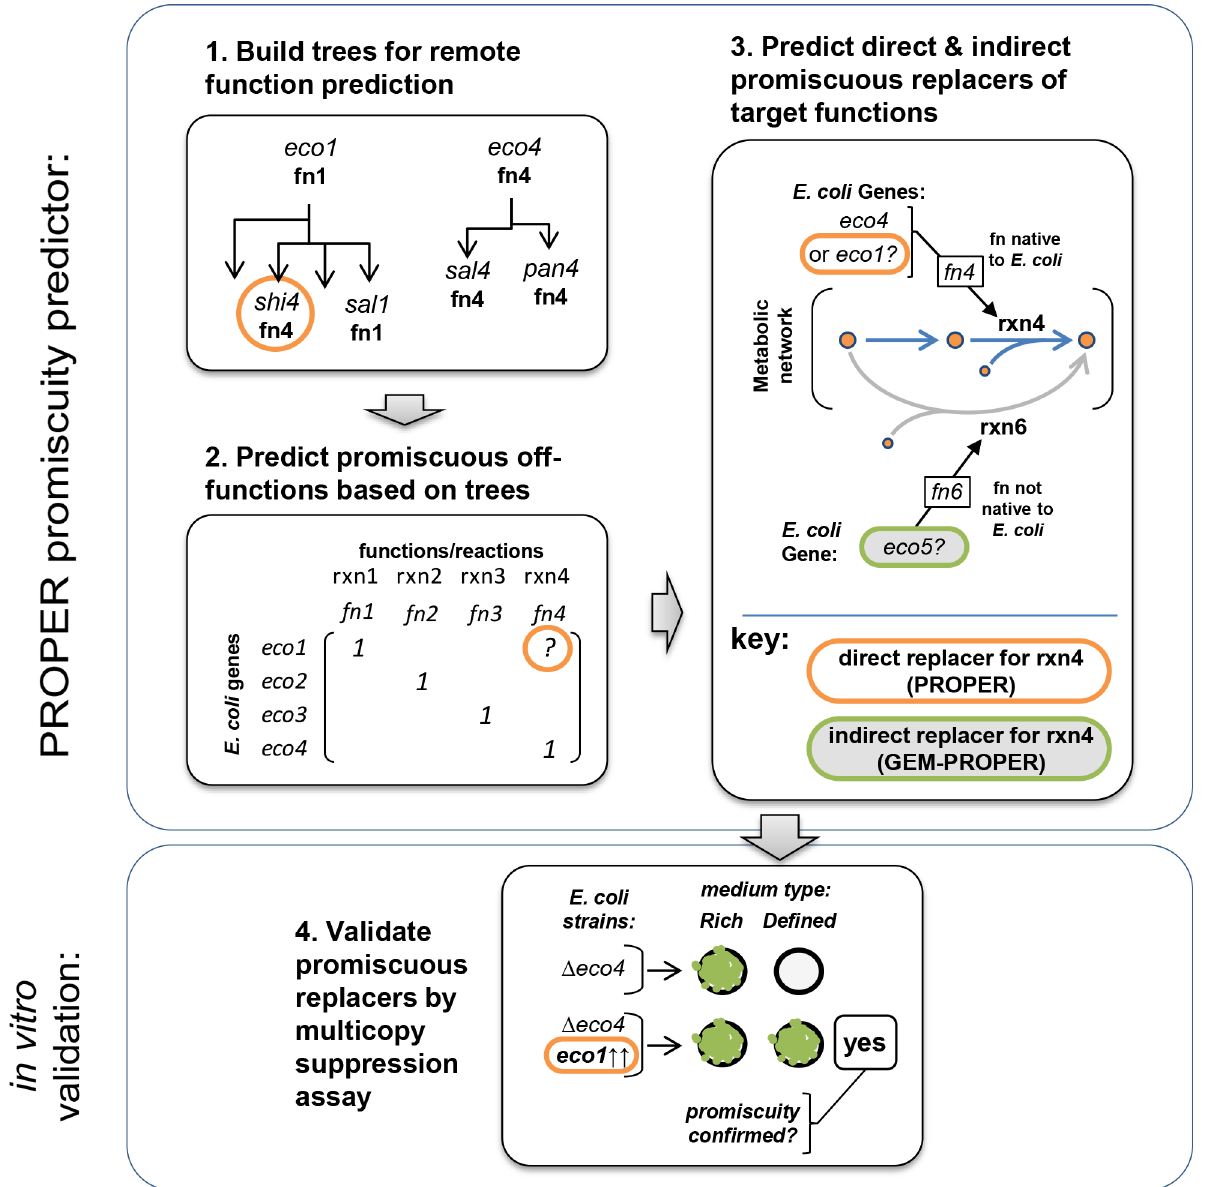
Fig 1. Schematic of prediction framework for promiscuous replacers. (1) Gene similarity trees are built around each gene in E . coli , including any distantly related gene in the RAST database. (2) A matrix is formed which links genes with their primary functions and also potential promiscuous functions. A gene (in this example, eco1 ) will take a potential secondary ‘ promiscuous ’ function in the matrix if its similarity tree includes any genes annotated with different functions (e.g., in this example, shi4 , which encodes function fn4). (3) Cases in which a gene ’ s predicted promiscuous function is identical to the function of another gene in E . coli constitute predicted ‘ direct ’ target-replacer gene pairs (via PROPER). We also predict ‘ indirect ’ target-replacer pairs where a replacer bypasses the target ’ s function (via GEM-PROPER). (4) Promiscuous activity of a ‘ replacer ’ gene can be confirmed for target-replacer pairs in which the target is conditionally essential on a minimal medium, via the multicopy suppression